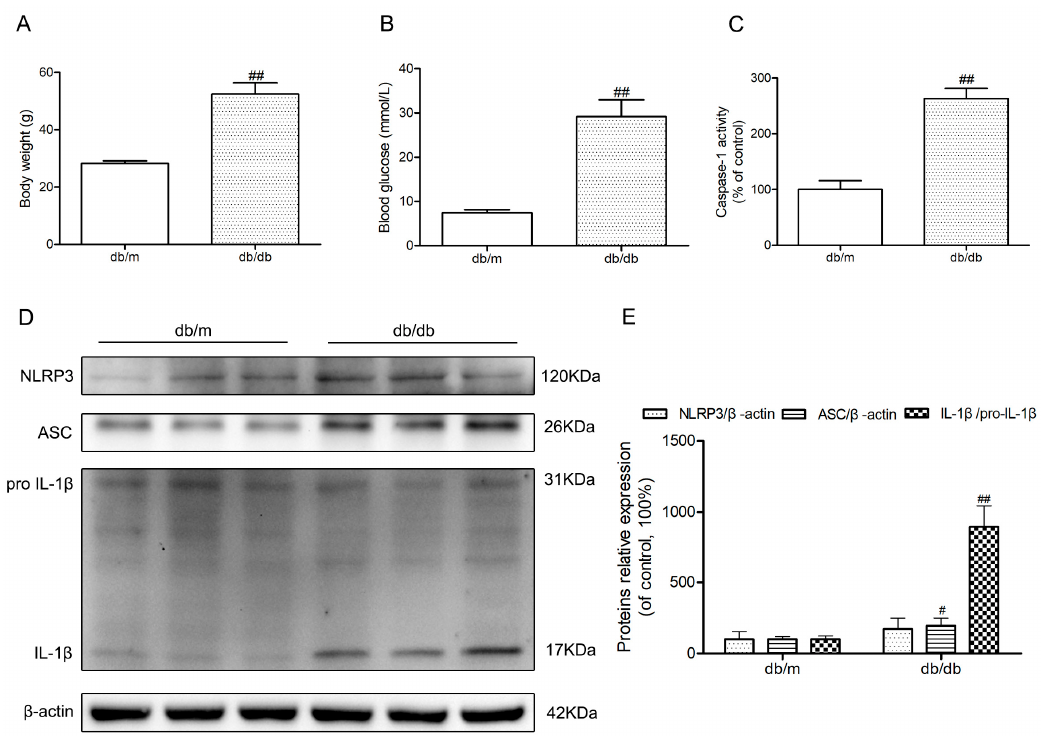
Figure 1. Activation of nucleotide-binding oligomerization domain-containing protein (NOD)-like receptor family, pyrin domain containing 3 (NLRP3) inflammasome in the hippocampus of db/db mice. ( A ) Body weights in mice of each group; ( B ) Fasting blood glucose in mice of each group; ( C ) Caspase-1 activity in the hippocampus of each group, as was reflected by the production of p -nitroaniline; ( D ) Western blot analysis of NLRP3 inflammasome-associated NLRP3, apoptosis-associated speck-like protein (ASC), interleukin (IL)-1 β , and β -actin were performed in the hippocampus of each group; ( E ) The relative protein expression of NLRP3 to β -actin, ASC to β -actin, and IL-1 β to pro-IL-1 β are expressed in the bar graphs. All data are represented as mean ± SD ( n = 3). ## p < 0.01, # p < 0.05, compared with the db/m-group.